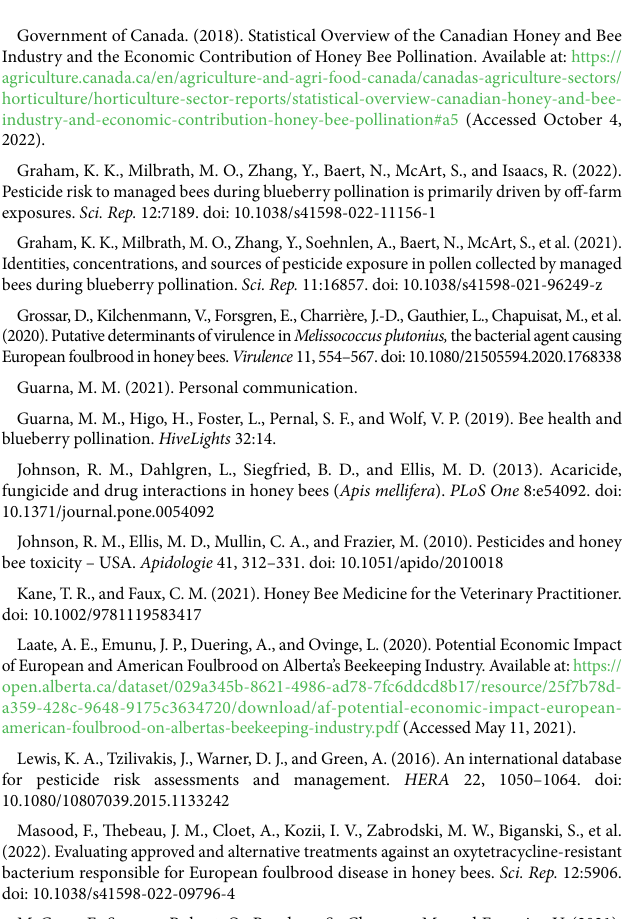
SUPPLEMENTARY FIGURE 2 Effects of chronic exposure to fungicidal products on larval survival from European foulbrood disease (EFB) in vitro until eclosion or emergence. Percent survival ± confidence interval of honey bee larvae infected with M. plutonius (dashed lines) and exposed to low concentrations of Luna and Switch (colored lines). Infected (I), fungicide-exposed larvae were compared to infected control larvae (IC). Survival analysis of data from day 0-18 Larvae monitored until emergence (A, C, E) yielded had the same statistical relationship between infected experimental groups compared to survival analysis of data from day 0-as when the same data was truncated to 6 days (B, D, F) . * p < 0.05, *** p < 0.001, by a Mantel-Cox log rank